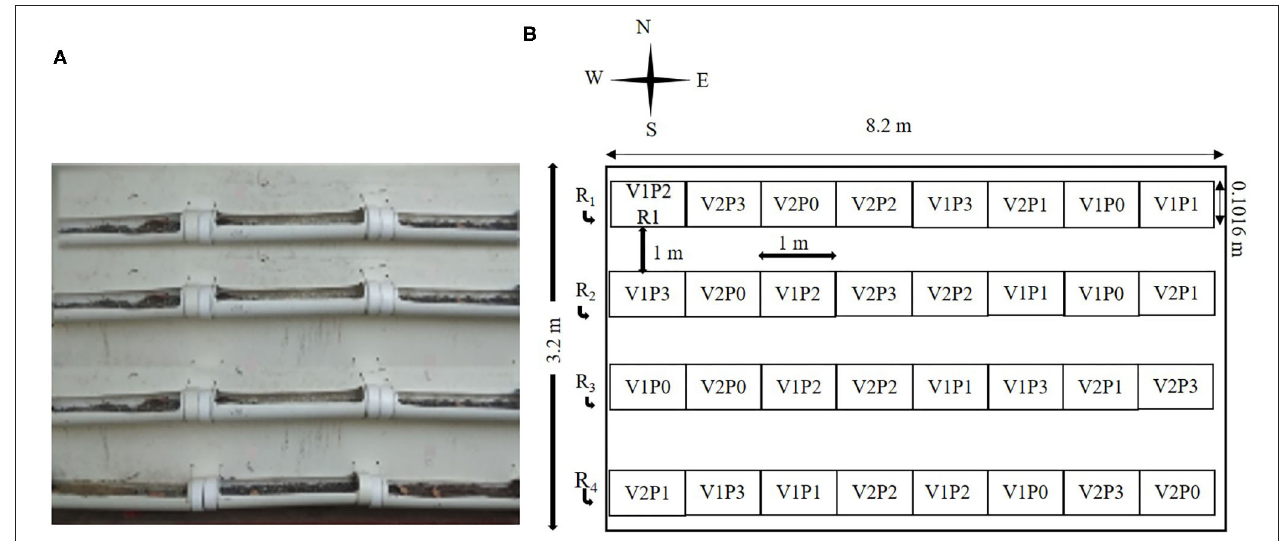
FIGURE 1 | Containers and lay-out of the experimental set-up for vertically grown lettuce in a building wall, Dhaka city, Bangladesh. Two lettuce cultivars ( Lactuca sativa cv. Green Wave, V1; Lactuca sativa cv. New Red Fire, V2) are grown in three different mixes of growing media (P0: control, 100% soil; P1: 40% soil + 40%